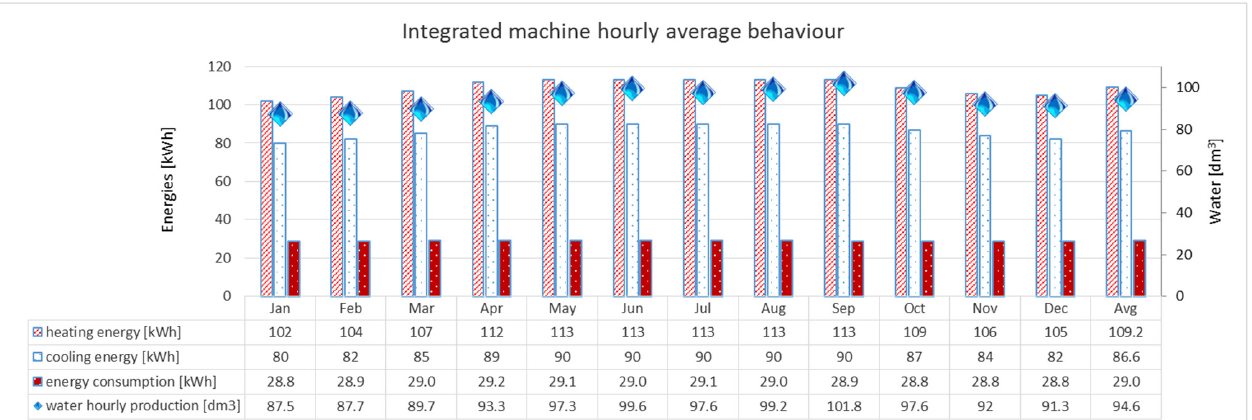
Figure 3. Integrated machine average hourly behaviour, month by month. Table 2. AWG-integrated machine hourly behaviour averaged over the year, expressed as water production, heating, cooling energy and energy consumption.